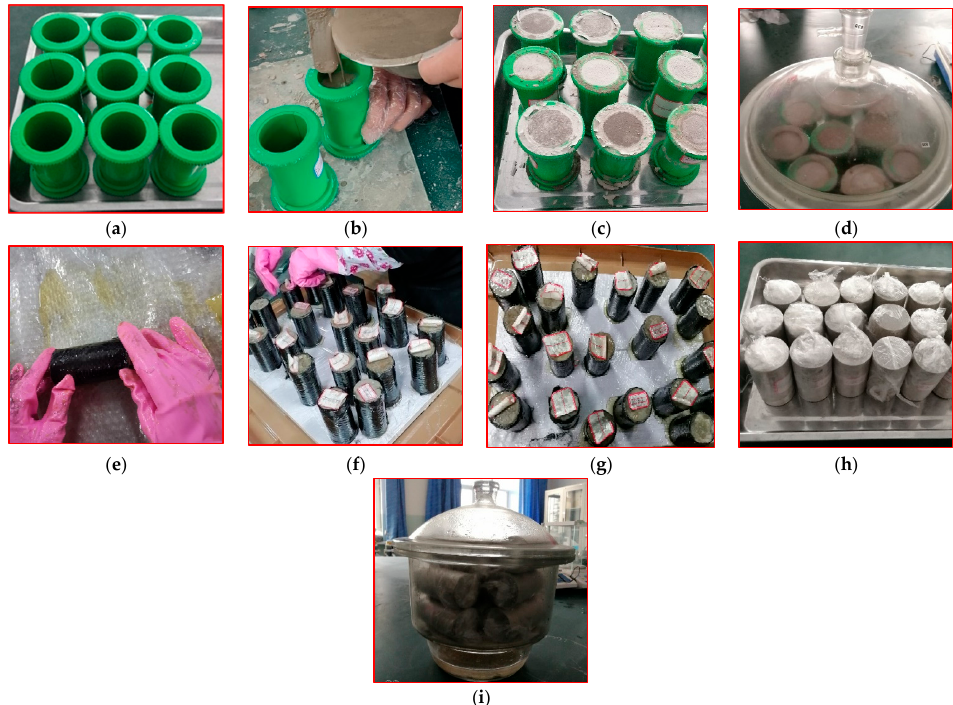
Figure 5. Preparation of specimens: ( a ) plastic model, ( b ) casting SBM; ( c ) curing SBM in the laboratory; ( d ) curing SBM in the dryer; ( e ) wrapping CFRP jacket; ( f ) strengthening specimens ends; ( g ) CFRP jacket curing; ( h ) covering with plastic sheet; ( i ) curing CSBM in the dryer.